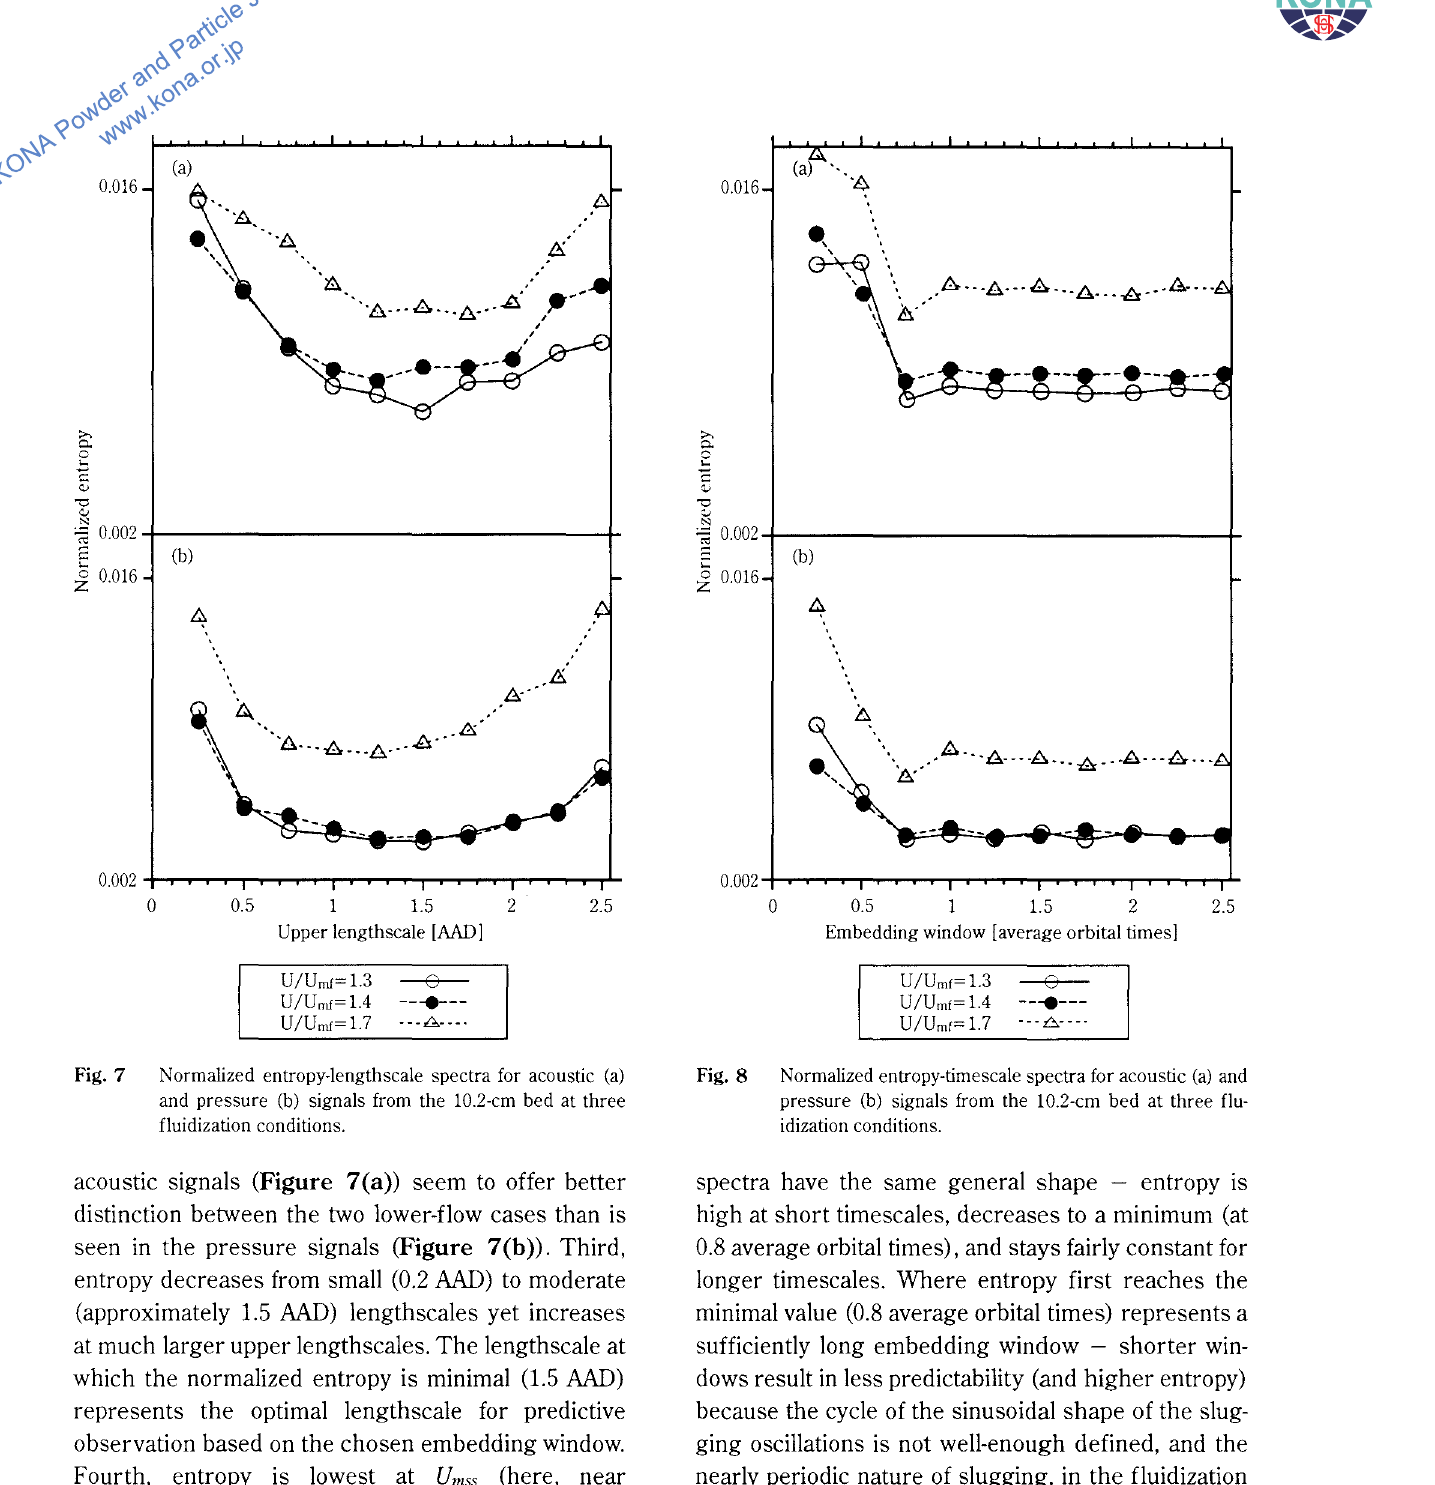
Normalized entropy-lengthscale spectra for acoustic (a) and pressure (b) signals from the 10.2-cm bed at three fluidization conditions.